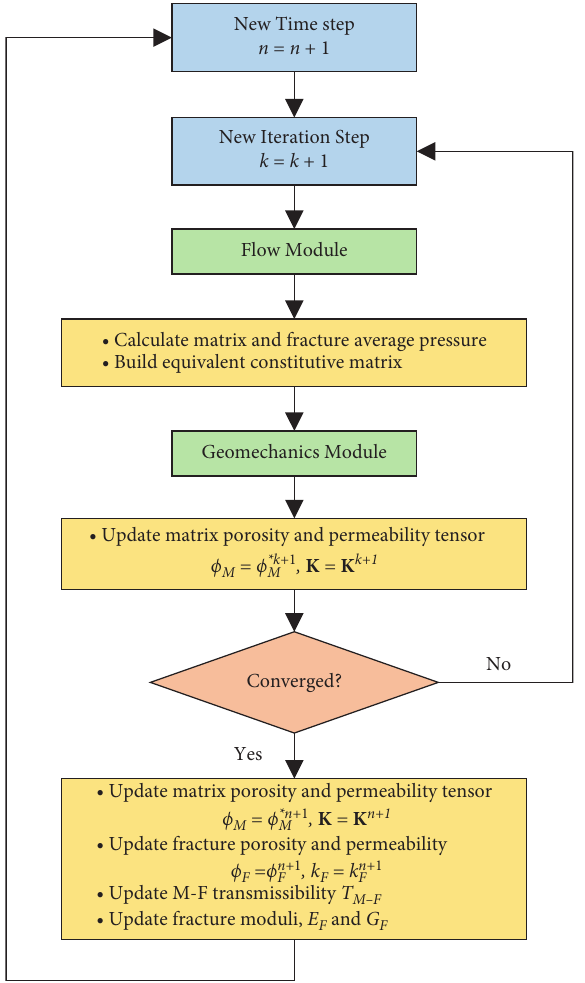
Figure 4: Flowchart of fixed-stress split